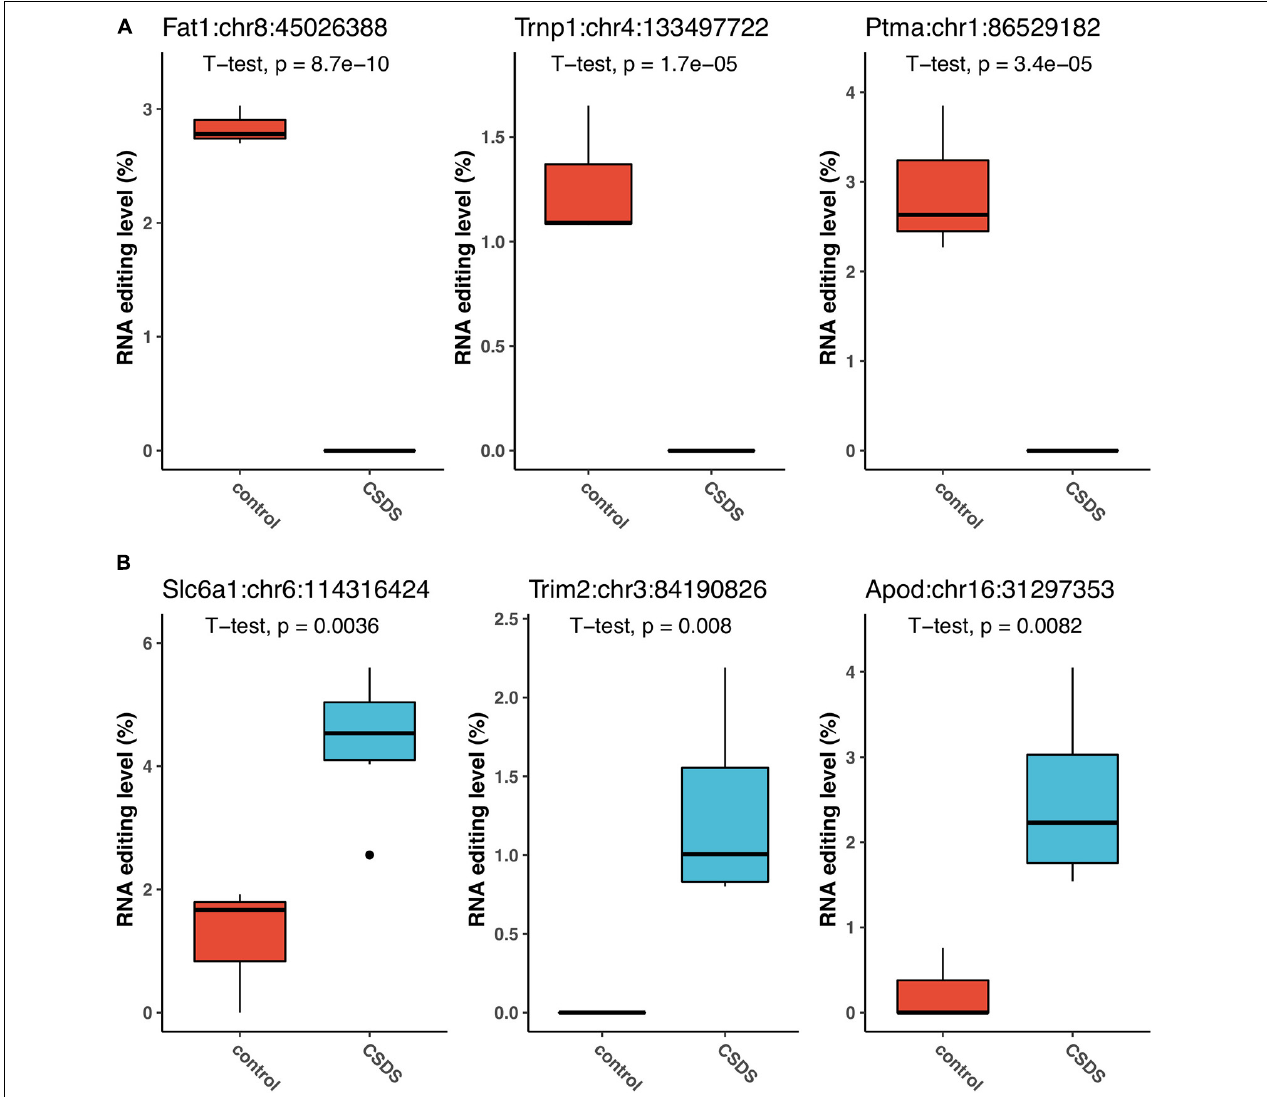
FIGURE 4 | The events that are the most significantly associated with CSDS. The top three upregulated events (A) , and top three downregulated events (B) in CSDS compared to controls are